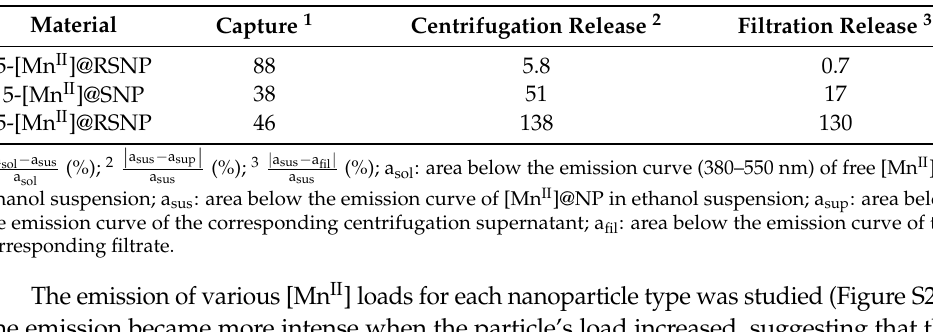
Table 2. Evolution of the integrate of the emitted intensity measured for all nanoparticle’s types loaded with Mn II